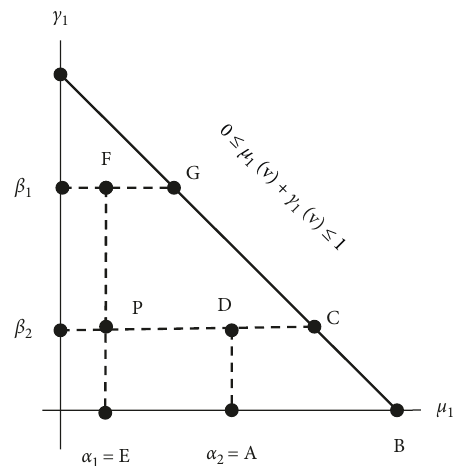
Figure 3: The comparison of V